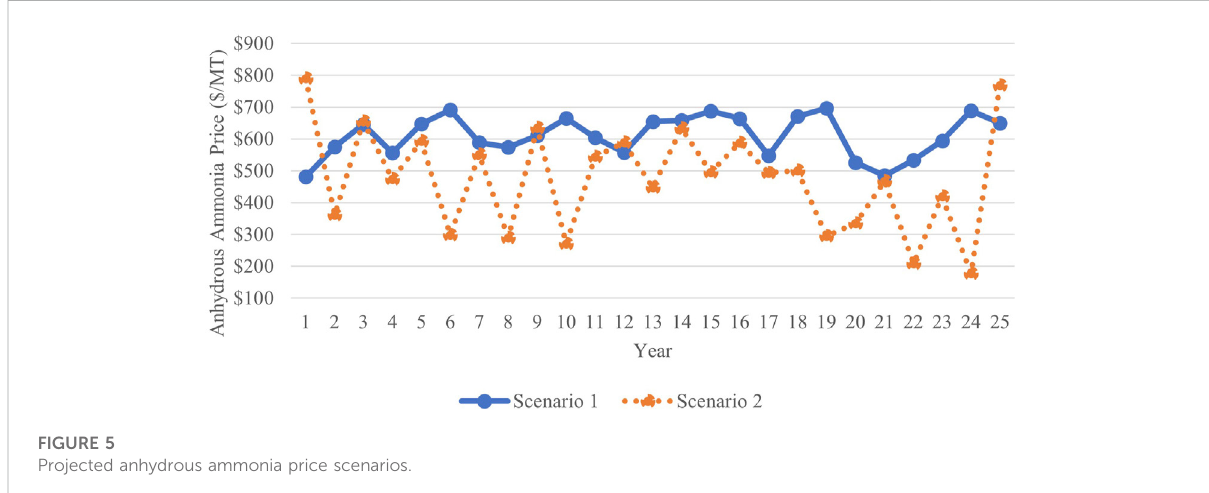
FIGURE 5 Projected anhydrous ammonia price scenarios.